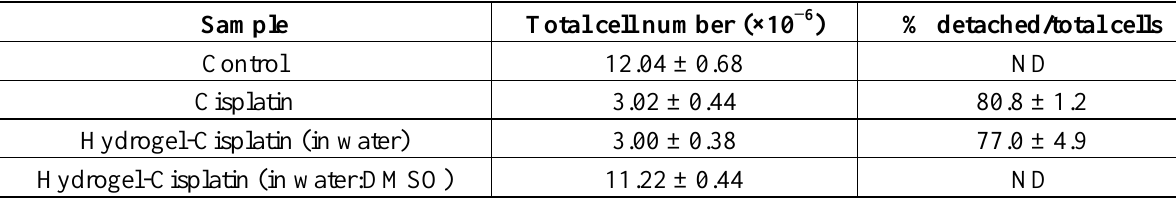
(1 μg/mL) or with cisplatin-loaded PHE-9 hydrogels (30 μg/mL, both). The percentages of detached cells on total cells in control (untreated) and in Hydrogel-Cisplatin (in water:DMSO) samples were minor, ranging from 2 to 5%. Results are given as mean ± SE from three to five